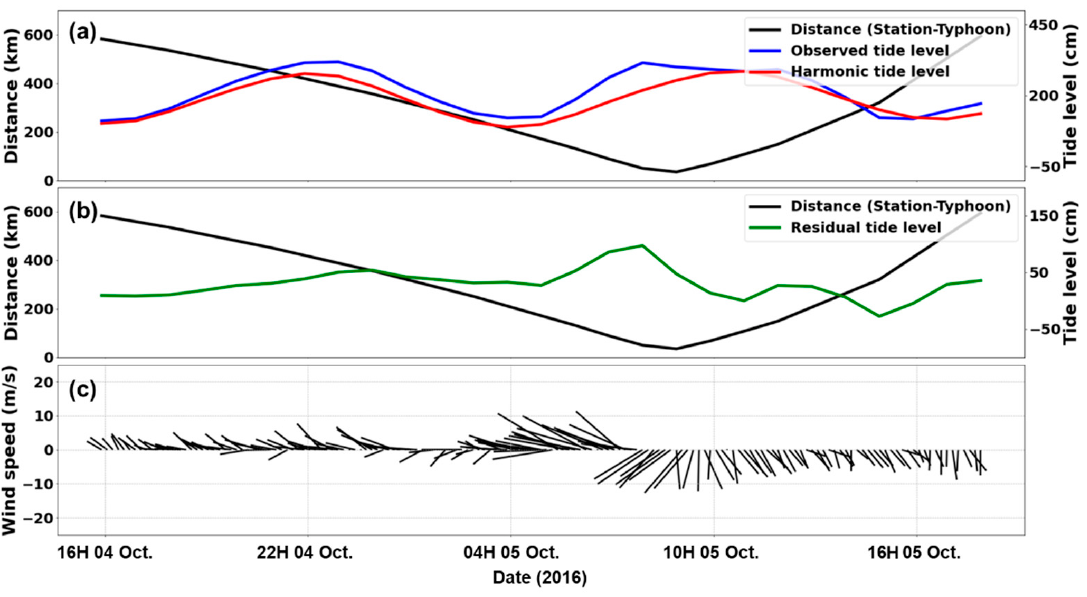
Figure 10. Time-series of observational data from Yeosu tidal station during Typhoon Chaba. ( a ) Astronomical tide, ( b ) residual tide level, and ( c ) wind components, where direction and length represent wind direction and speed, respectively.